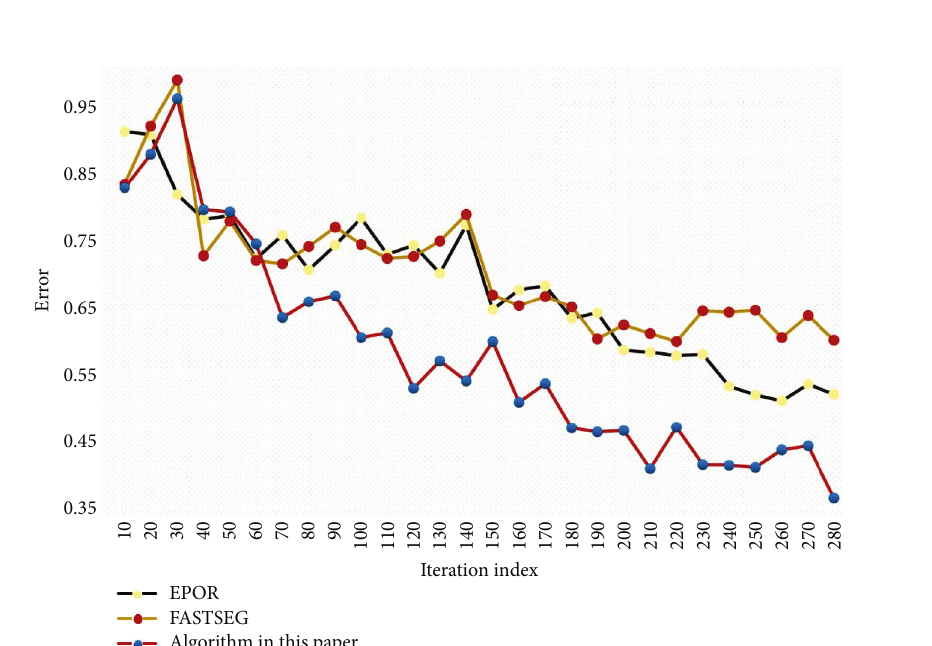
Figure 4: Error of the